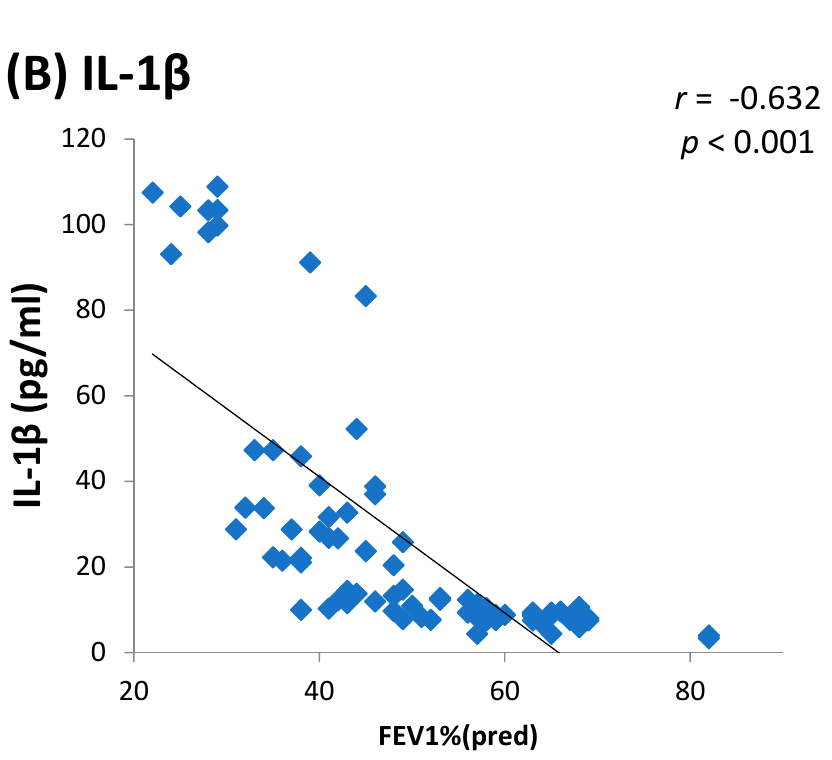
Figure 5. Correlation between levels of ( A ) TNF- α (pg/mL), ( B ) IL-1 β (pg/mL), and Forced expira- tory volume is 1 st second FEV1%(pred) among the cases.